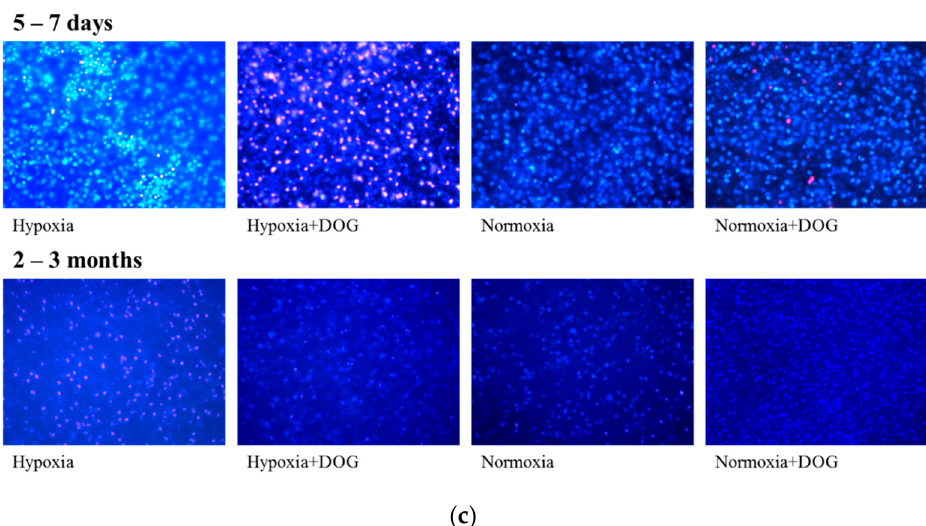
Figure 2. The effect of hypoxia and simulated ischemia on cell death in brain slice cultures from 5–7 days and 2–3 months old rats. After 24 h hypoxia or hypoxia with 10 mM D-deoxyglucose (DOG), the level of necrosis was evaluated by measuring increase in lactate dehydrogenase (LDH) activity in the slice culture medium ( a ) and PI fluorescence in the slice cultures ( b ). FU—arbitrary fluorescence units. Representative fluorescence microscopy images of brain slice cultures stained with PI (red fluorescence) and Hoechst-33342 (blue fluorescence) are presented in ( c ). The data are presented as means ± standard errors of 7–18 experiments on separate brain slices cultures. **— p < 0.01; ***— p < 0.001 compared to normoxic control with DOG, ###— p < 0.001 compared to normoxic control without DOG.